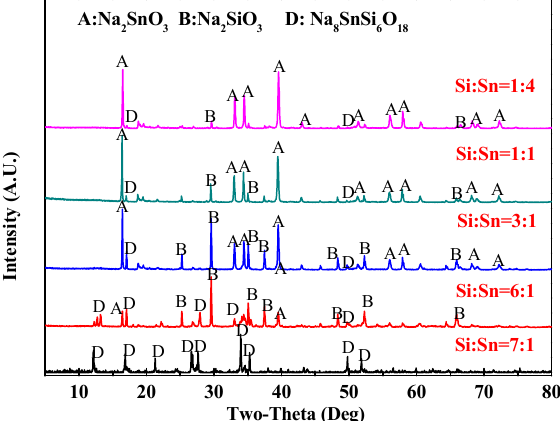
Figure 8. XRD patterns of the samples with different SiO 2 /SnO 2 mole ratio (Temperature: 875 o C; Time: 60 min).